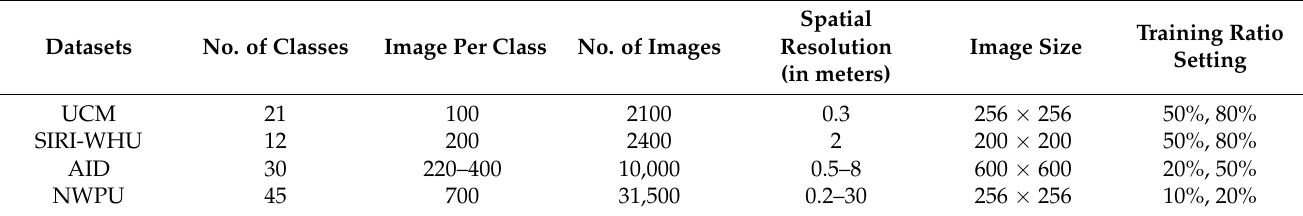
Table 1. Information on the four